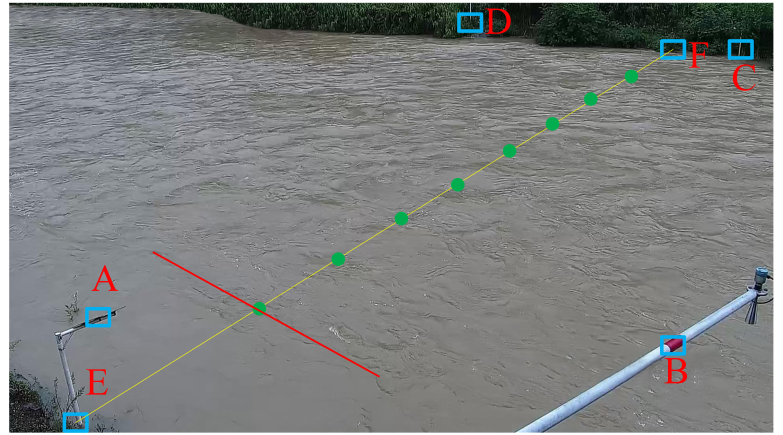
Figure 8. Ground control points (GCPs) and velocity-measuring